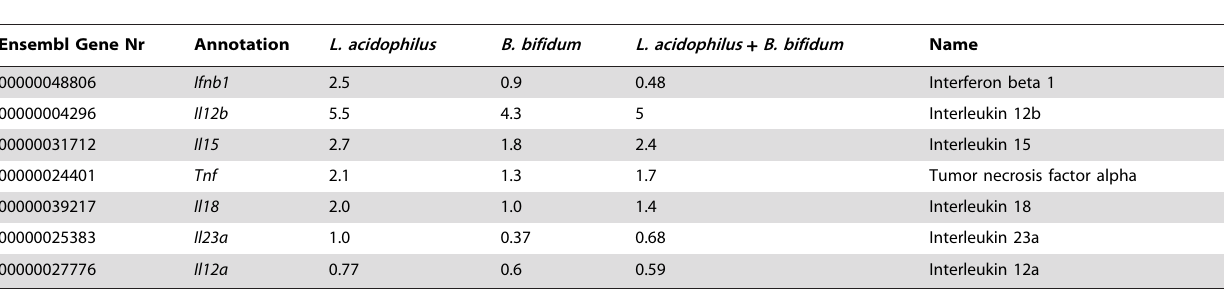
Table 4. Inhibitory Effects of Bifidobacterium bifidum Z9 on the Cytokine Expression in Lactobacillus acidophilus NCFM stimulated Dendritic